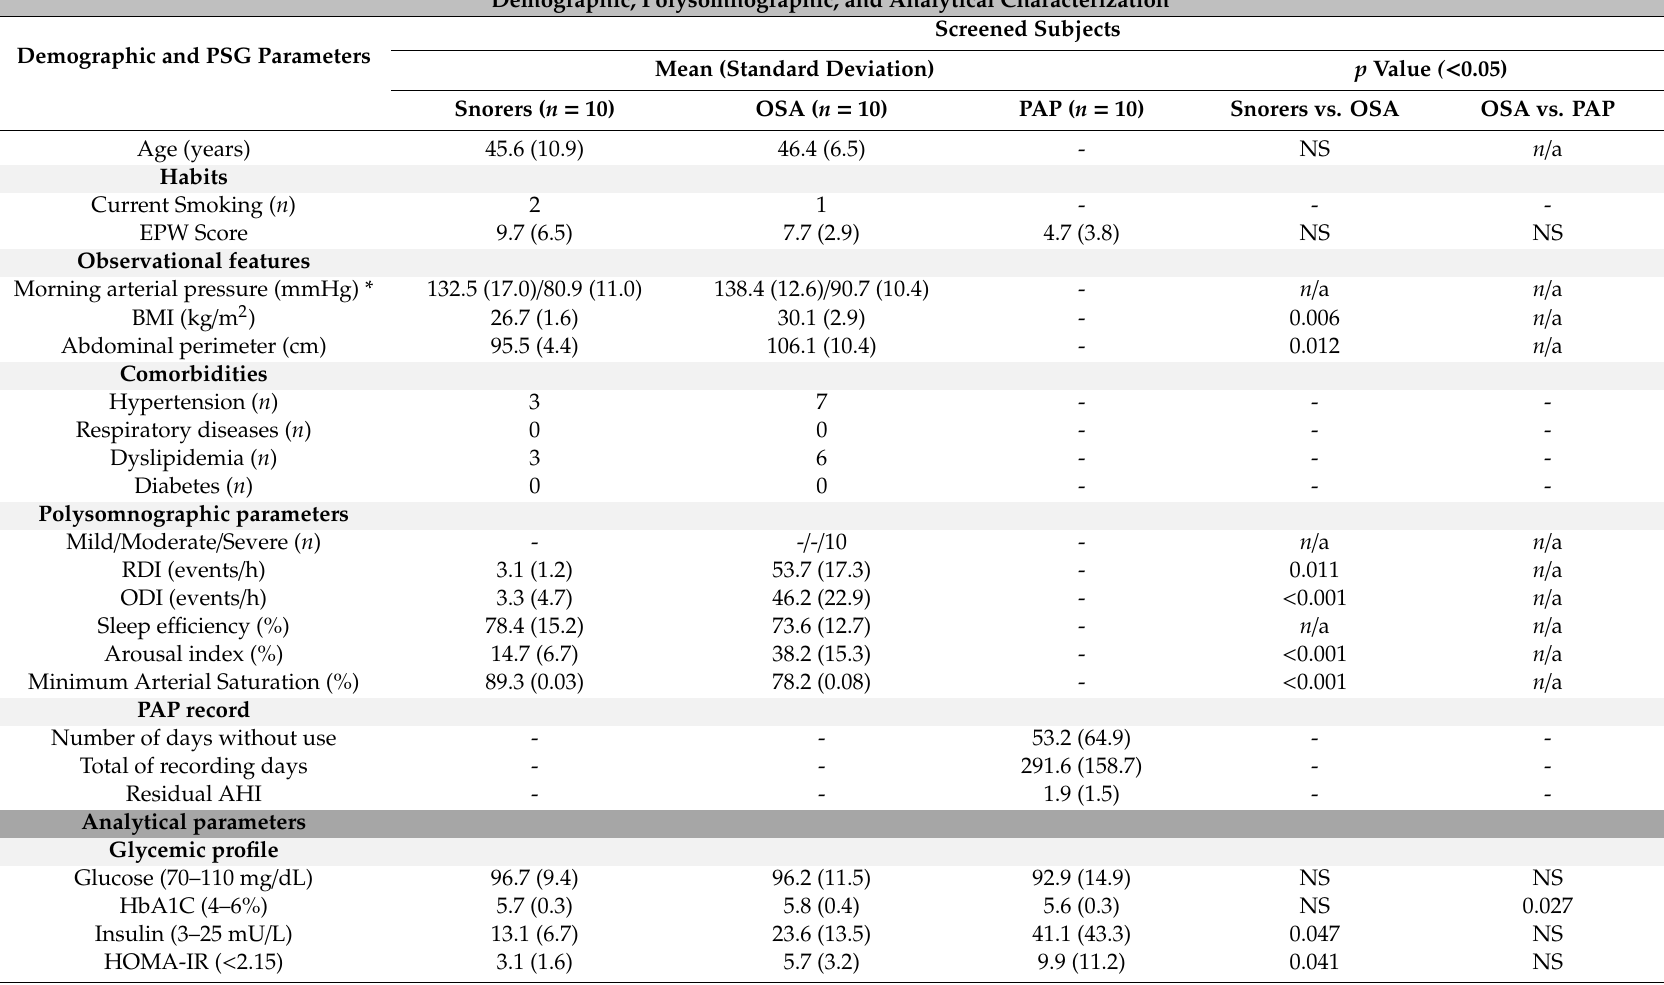
Table 1. Cohort I—Discovery